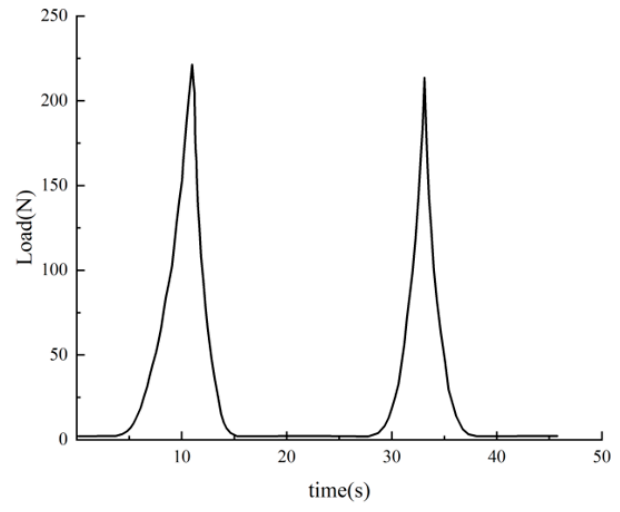
Figure 16. TPA characteristic curve of typical wakame stem.